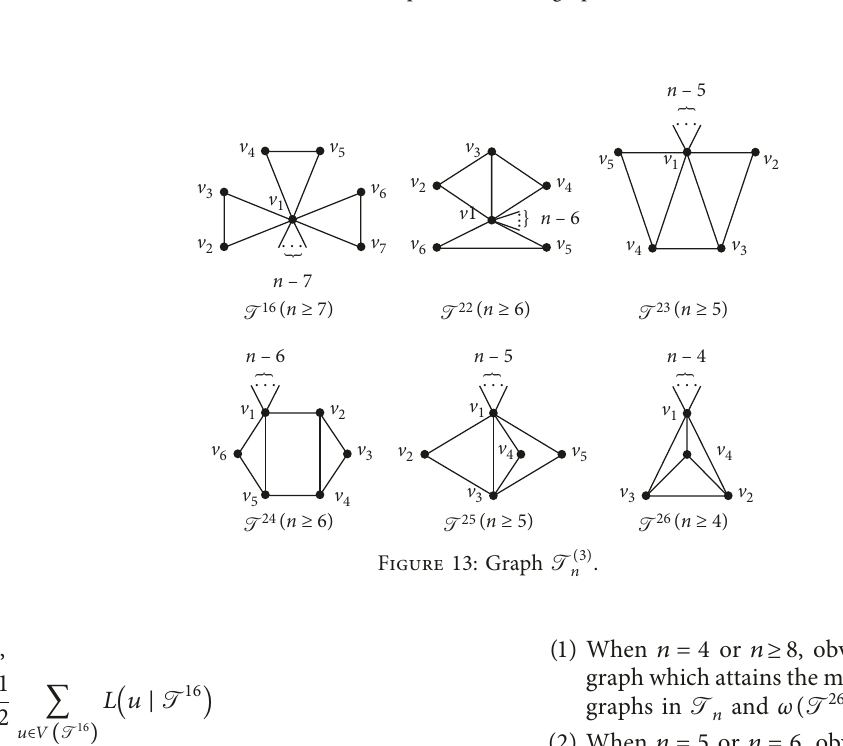
Figure 12: Operation IV on graph G